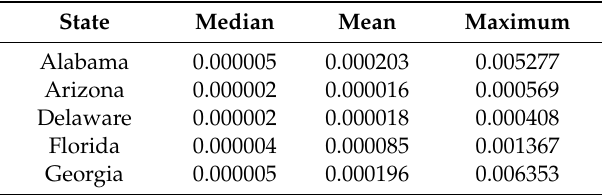
Figure 5. Maximum, mean and median error in transition probability estimation for all 49 transitions in Georgia, USA from 2011 to 2021. Table 1. Highest median, mean and maximum errors in transition probability across all 49 transitions, by state.